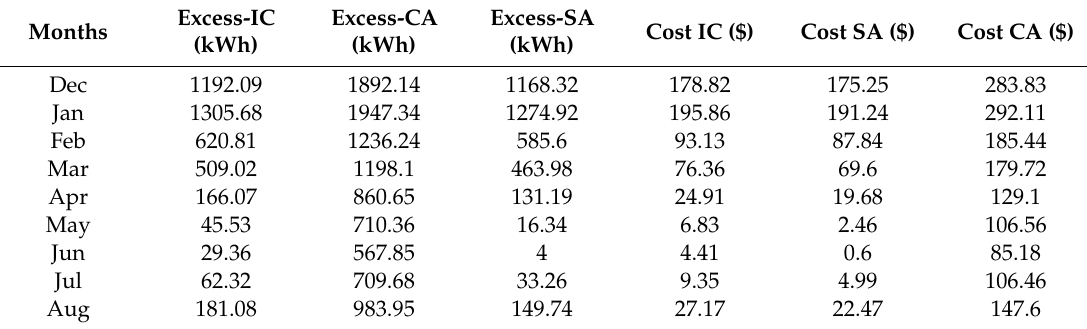
Table A2. Total monthly excess energy and costs obtained from three strategies at Evermore.